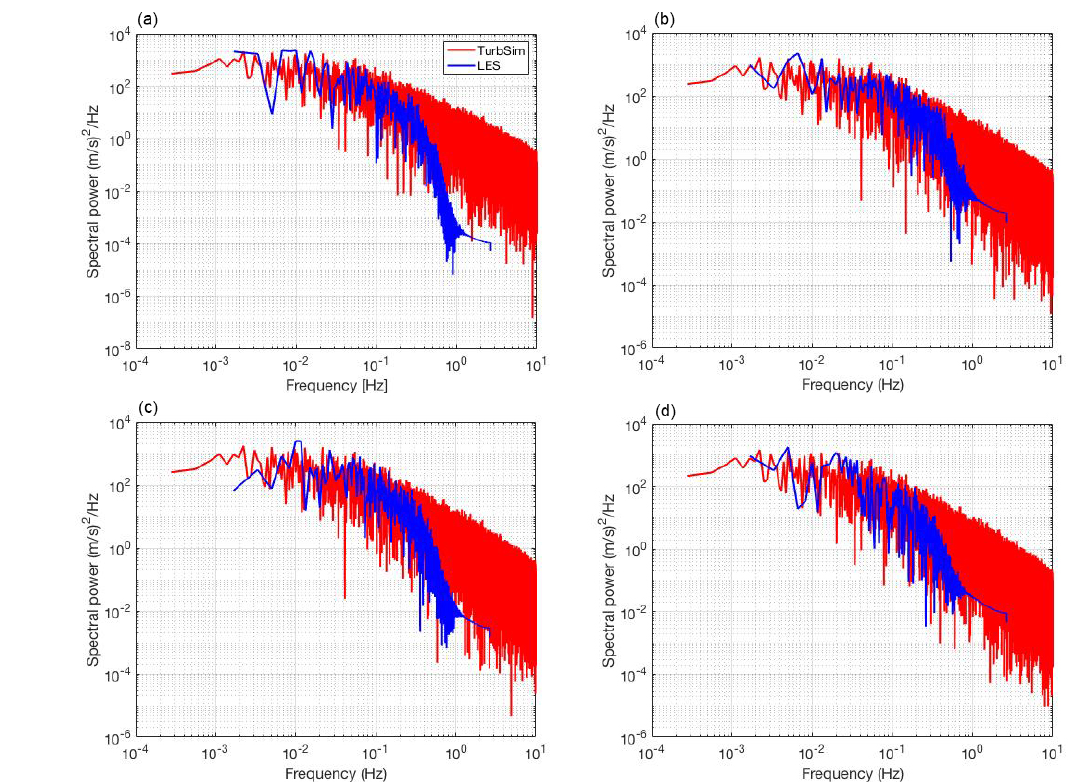
Figure 6. Power spectral density comparisons of the LES and TurbSim 10min wind field simulations at hub height at four different radii from the hurricane